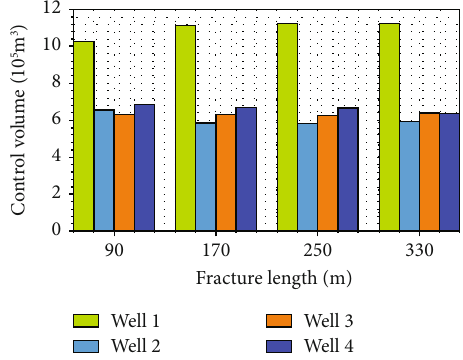
Figure 12: Comparison of the control volumes of the production wells with di ff erent fracture